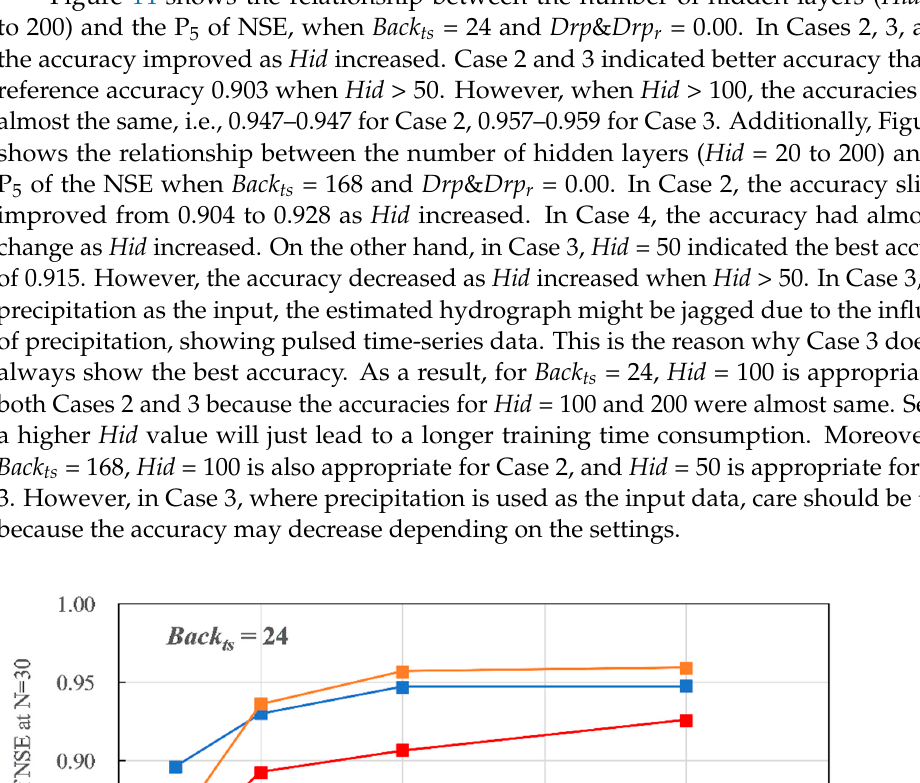
Figure 13. Influence of dropout and recurrent dropout on the 5th percentile of NSE.